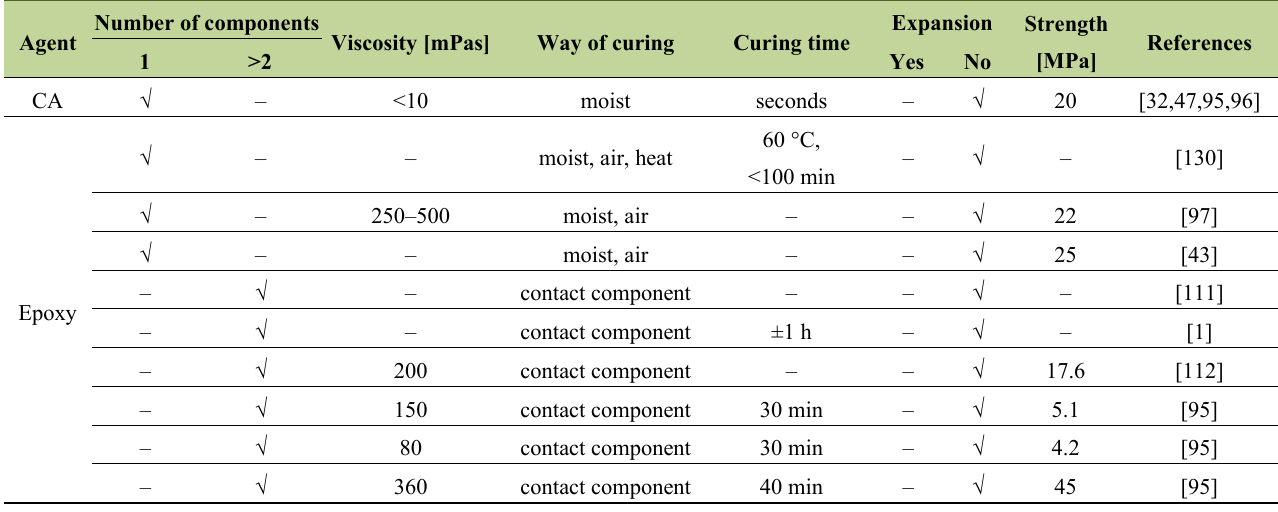
Table 1. Overview of the healing agents which have been reported in the